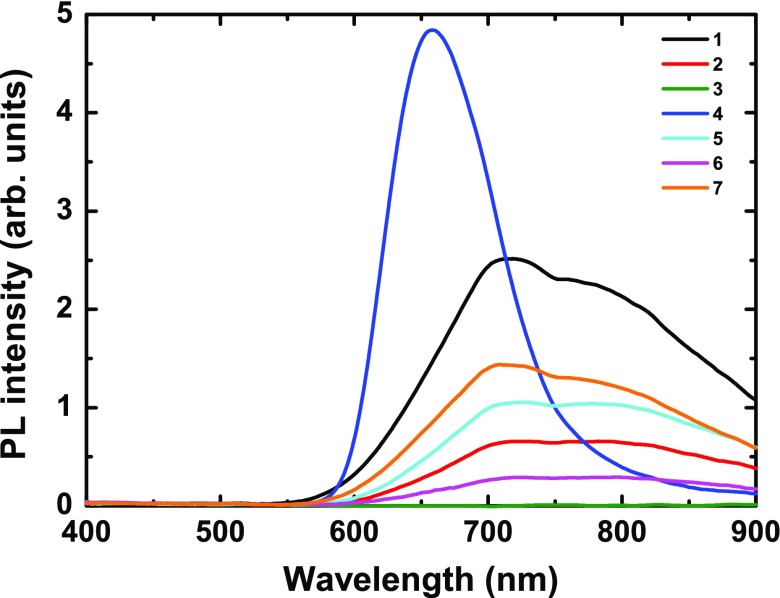
PL spectra of 1–7 compound series (λexc = 325 nm).